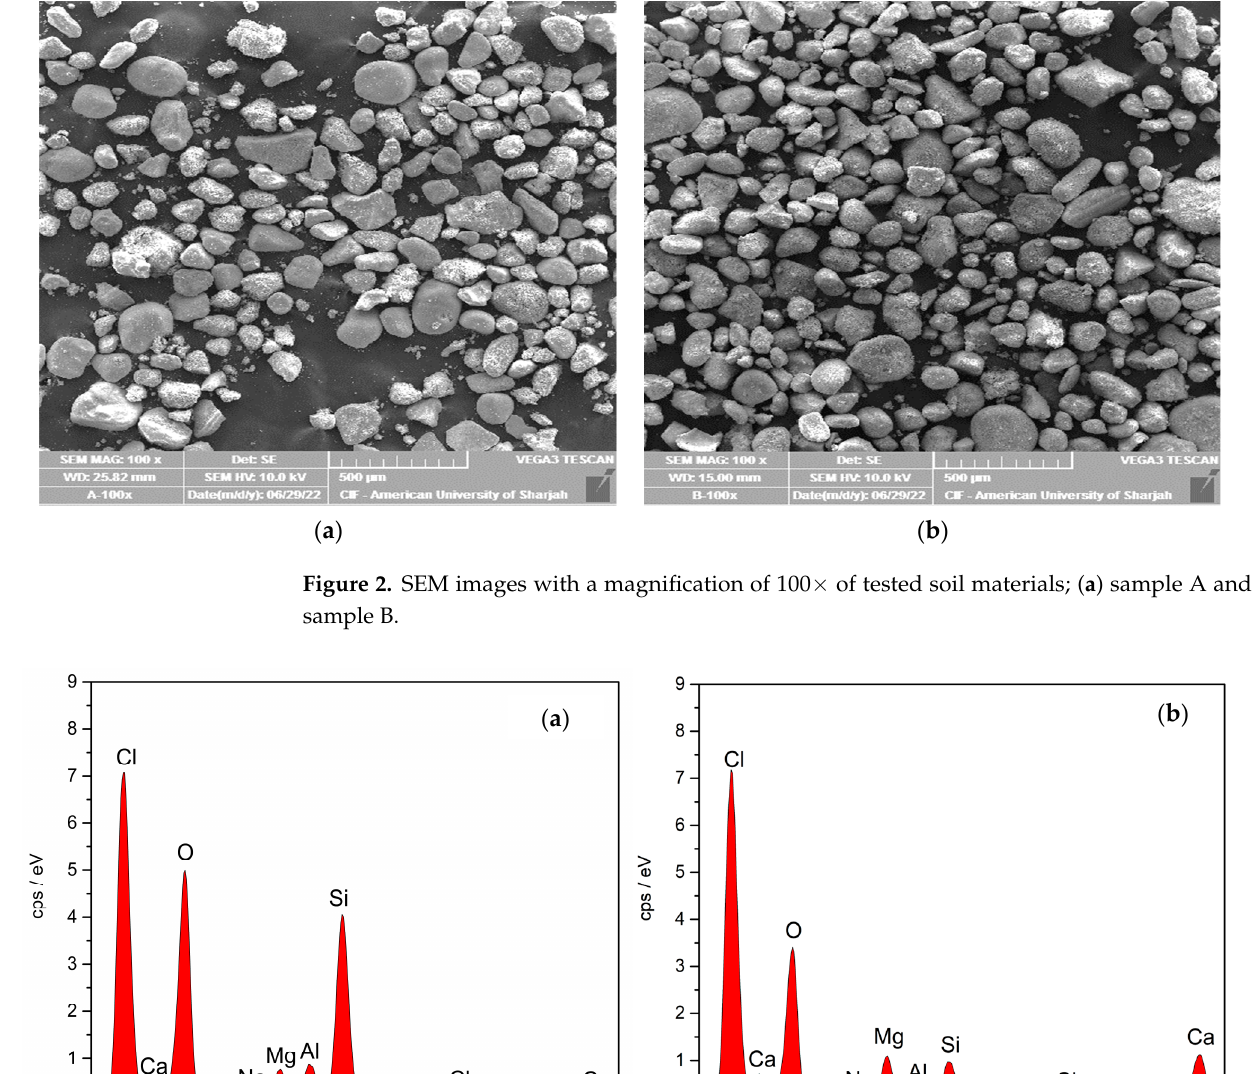
Table 4. Summary of the chemical compositions of tested soil samples.